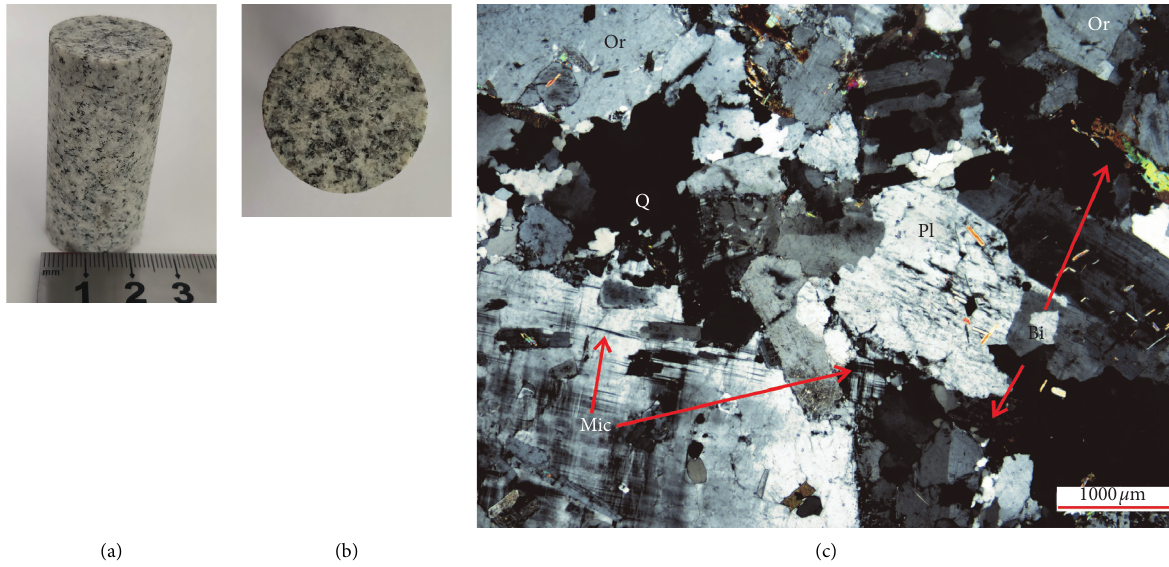
Figure 1: The granite specimens: (a) close-up view of a specimen; (b) end face of a specimen; (c) photomicrograph of a thin section of a pretest specimen (Or: orthoclase, Q: quartz, Mic: microcline, Pl: plagioclase, and Bi: